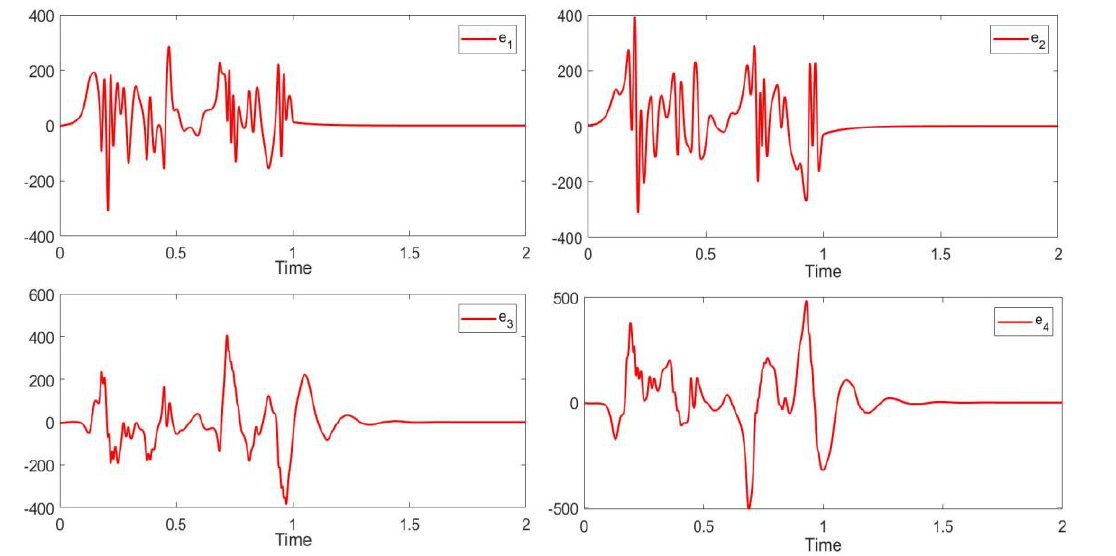
Fig. 7. Error of the Synchronization of two hyper chaotic Qi systems.